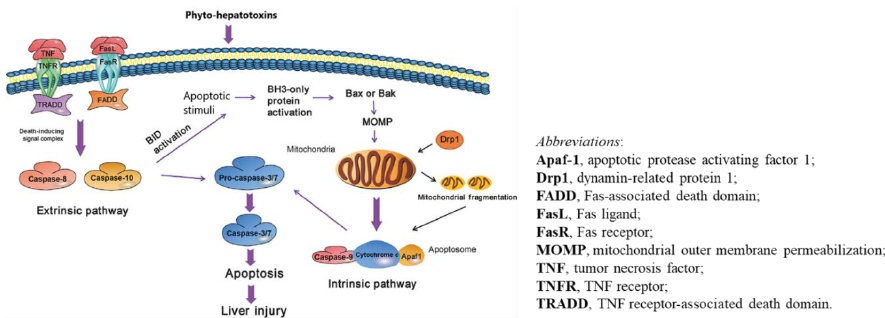
Figure 3. Phyto-hepatotoxins induce liver injury through oxidative stress. The mechanic pathway is derived from a published report by Xu et al. [109]. Int. J. Mol. Sci. 2020 , 21 , x FOR PEER REVIEW